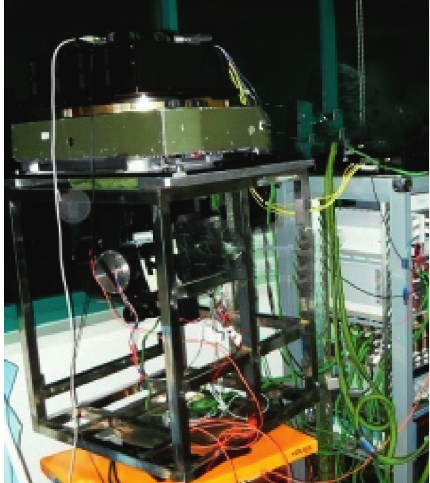
Figure 3: Inertial stabilization